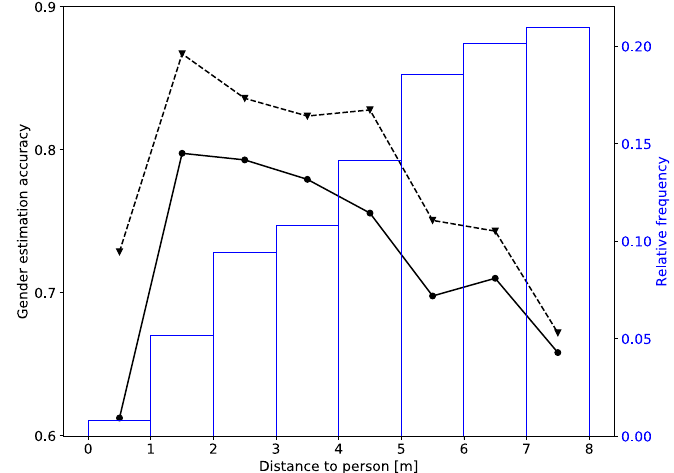
Figure 8. Dependence of the gender estimation accuracy on the distance to the person: solid line—instantaneous estimate; dashed line—sequential estimate. The figure also shows the distribution of the distances in the testing dataset (first day from real world dataset).